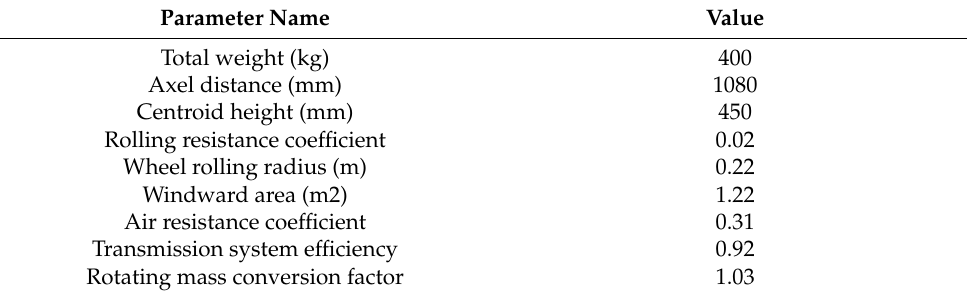
Table 1. Vehicle simulation parameters.